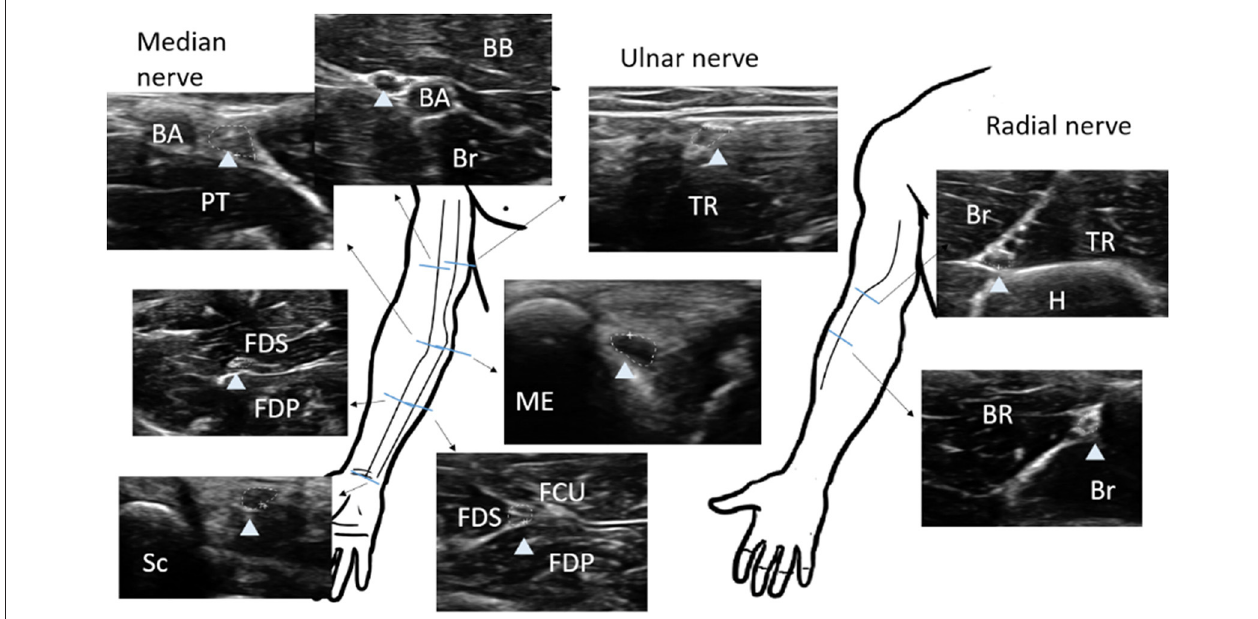
FIGURE 1 | Sites of nerve ultrasonography to determine the cross-sectional area (CSA) in the median, ulnar, and radial nerves. The CSA of each nerve (arrow head) is measured within the hyperechoic rim (dotted line). Median nerve sites: wrist, mid-forearm, antecubital fossa, and mid-arm. Ulnar nerve sites: mid-forearm, cubital tunnel, and mid-arm. BA, brachial artery; BB, biceps brachii; Br, brachialis; FCU, flexor carpi ulnaris; FDS, flexor digitorum superficialis; FDP, flexor digitorum profunuds; ME, medial epicondyle; SB, scaphoid bone; PT, pronator teres; TR, triceps.